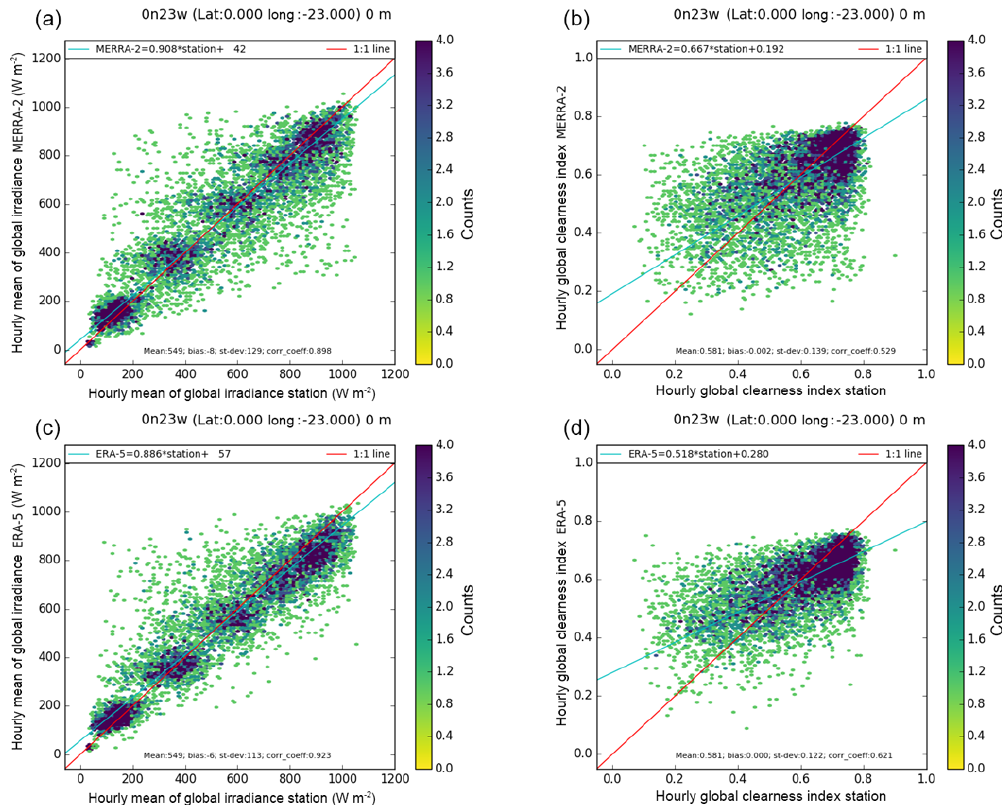
Figure C4. The 2-D histograms of PIRATA measurements (horizontal axis) and data sets (vertical axis) at 0 ◦ N, 23 ◦ W for E and KT. MERRA-2: (a) and (b) ; ERA5: (c) and (d) . Ideally, the dots should lie along the red line (1:1 line). The blue line is the affine function fitted over the points and should ideally overlay the red line.